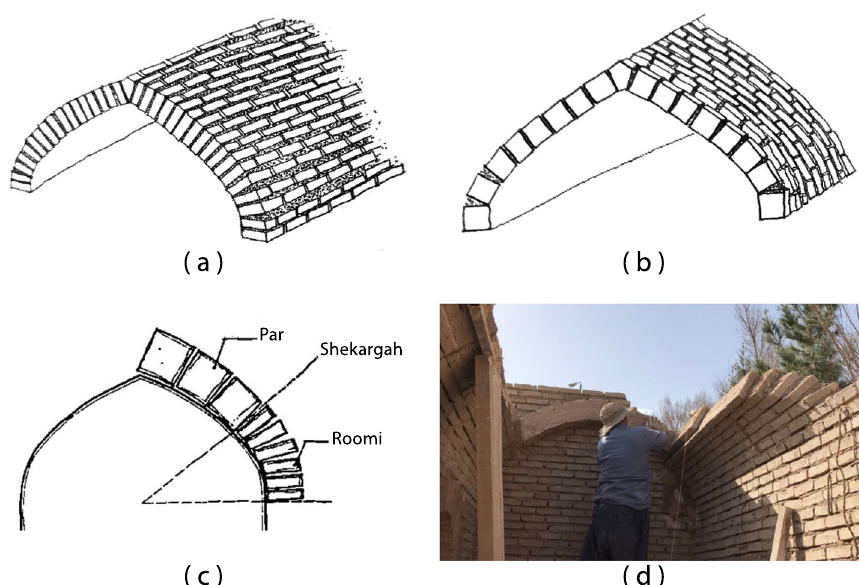
Fig. 14 Different vernacular practices for vault construction in Yazd: ( a ) Roomi, ( b ) Par, ( c ) hybrid techniques (Source of a‑c: adapted from Golabchi and Dizaji, 2016) and ( d ) application of the hybrid method in the Green guesthouse in Yazd University (Source: Arman